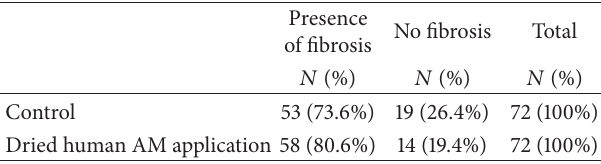
Table 2: The number of sagittal sections with and without fibrosis among 24 eyes of rabbits (6 sagittal sections per eye) after strabismus surgery according to the treatment (eyes with dried human AM application versus control eyes). Presence No fibrosis Total of fibrosis 𝑁 (%) 𝑁 (%) 𝑁 (%) Control 53 (73.6%) 19 (26.4%) 72 (100%) Dried human AM application 58 (80.6%) 14 (19.4%) 72 (100%) ( P = 0.428, Fisher’s exact